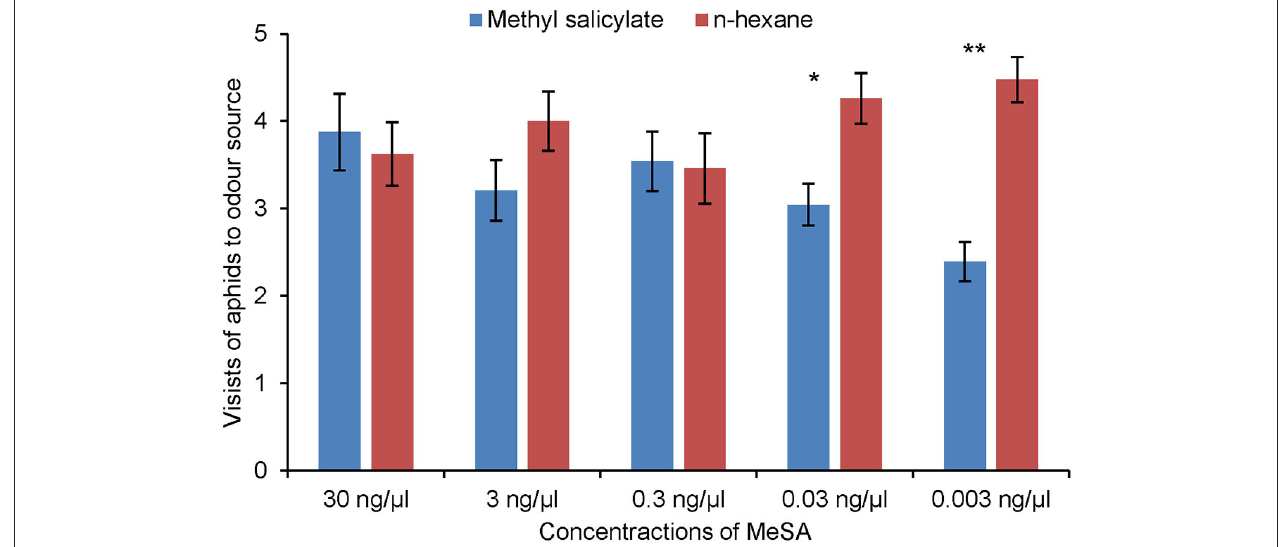
FIGURE 7 | Olfactory response of R. padi (mean visits in olfactometer arm ± SE) to different concentrations of MeSA compared with control (hexane). * p ≤ 0.05; ** p ≤ 0.01 after Wilcoxon matched pairs tests. Ideally, the dynamics between re-release and de novo production after MeSA exposure should be studied over a longer period of plant development and in a field